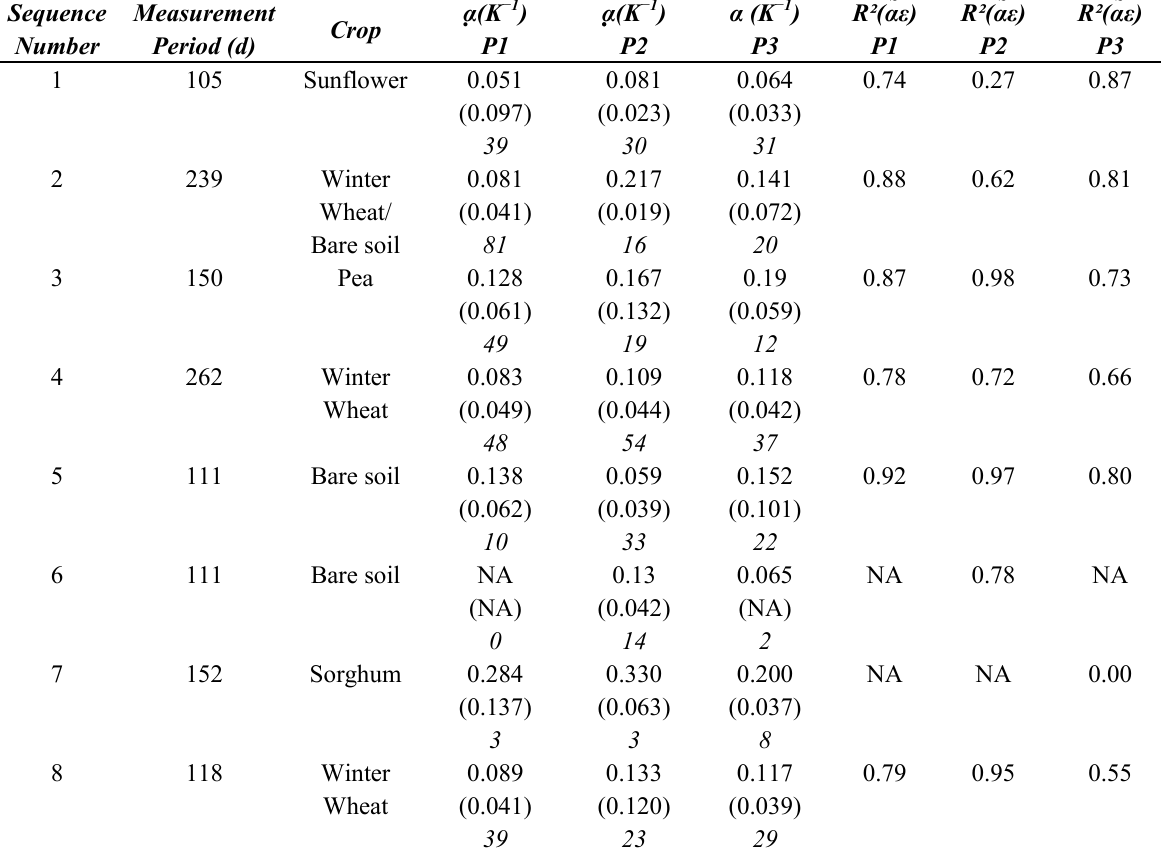
Table 2. Temperature correction factor results obtained with the three EC-10 CPs (P1, P2 and P3) and the eight measurement periods at the INRA-Avignon Observatory. Three types of data are given for α : the average value over the measurement period, the standard deviation (in brackets) and the number of days allowing the computation of α . R² is the coefficient of determination between α and ε